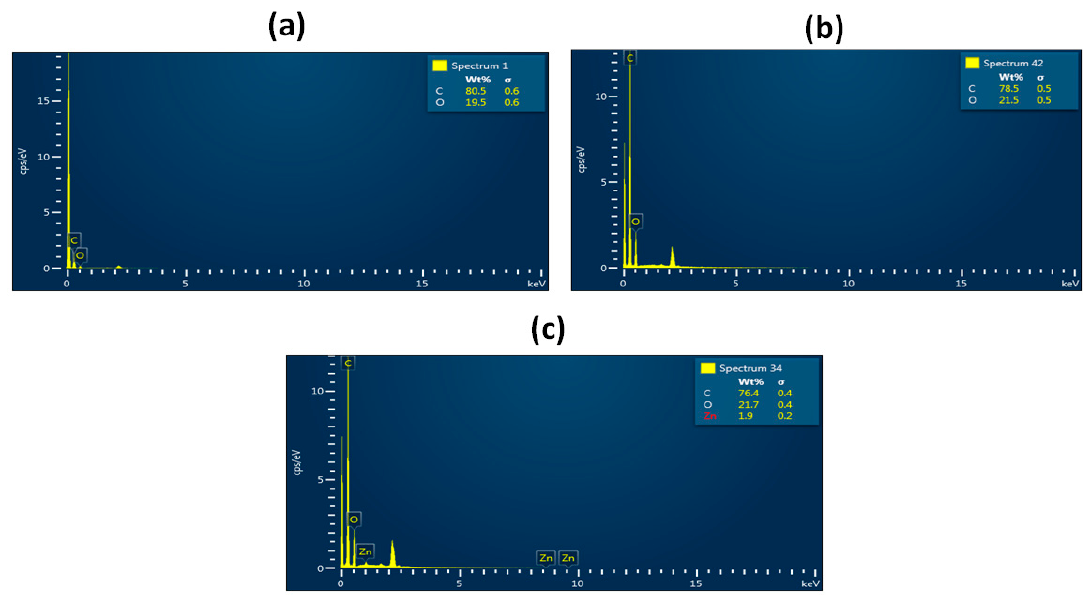
Figure 2. Energy Dispersive X-Ray Spectroscopy (EDX) of ( a ) PU, ( b ) PU/YY and ( c ) PU/YY/ZnNO 3.